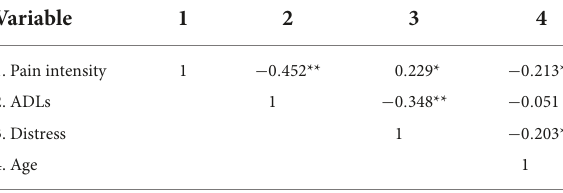
TABLE 3 Correlation matrix for pain intensity, distress, ADLs and age, N = 123. Variable